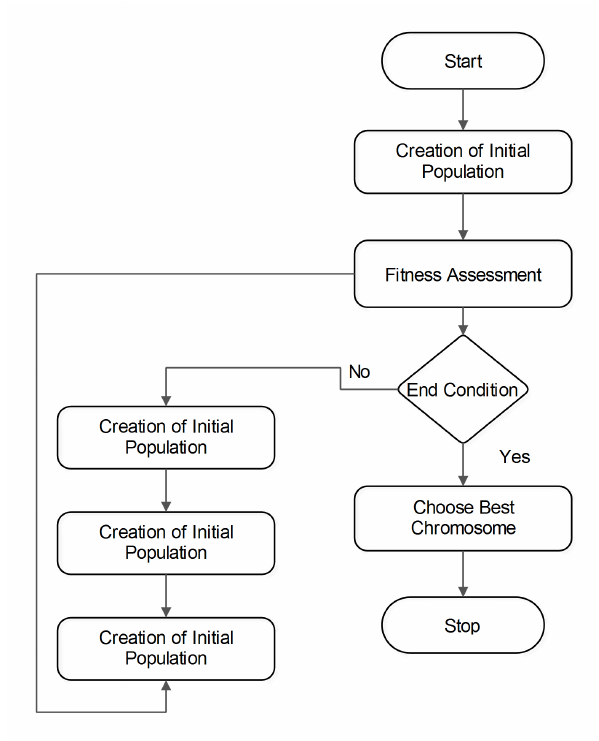
Figure 6. The genetic optimisation